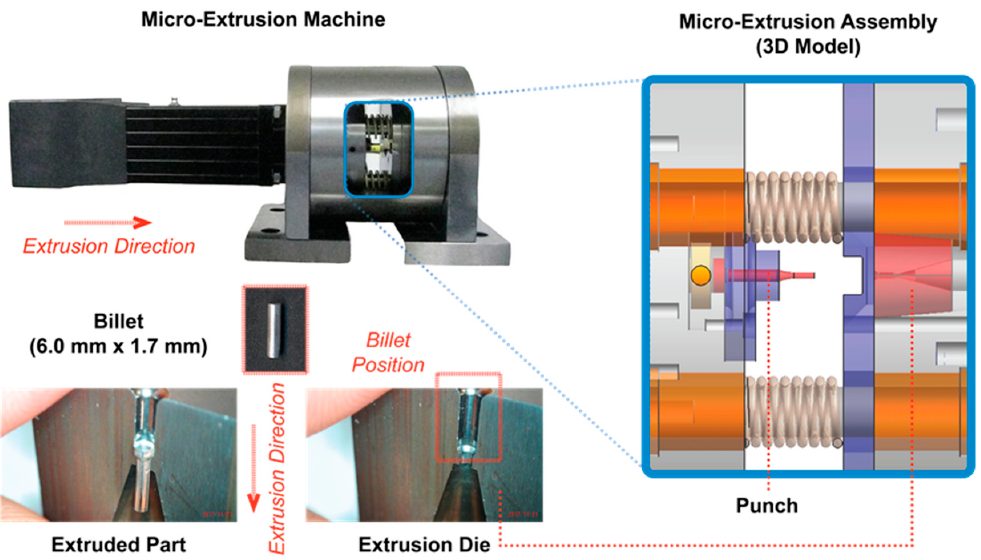
Figure 1. The micro-extrusion machine with the assembly model, and the micro-extrusion setup.